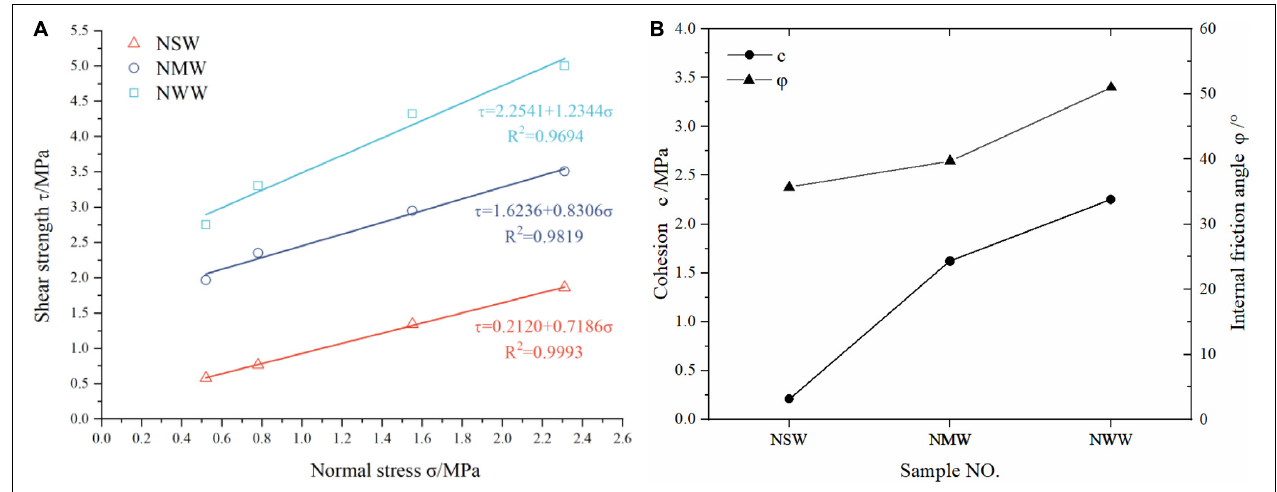
FIGURE 9 | Shear strength parameters of numerical models according to the Mohr–Coulomb criterion. (A) Direct shear test results and Mohr–Coulomb fits. (B) Cohesion and internal friction angle.